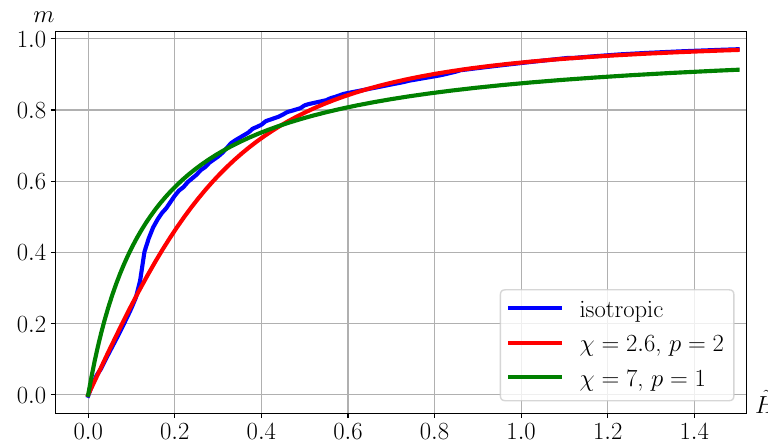
Figure 10. Magnetization curves obtained numerically and with the generalized Fröhlich-Kenelly